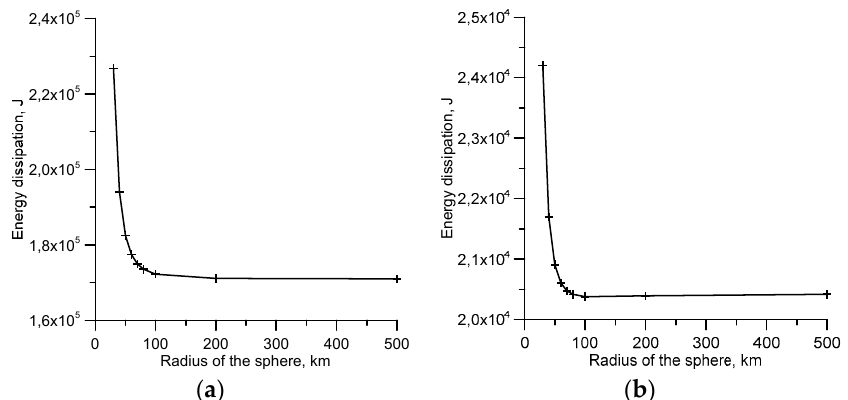
Figure 13. Energy transported through hemispheres of di ff erent radii all having their center at the strike point. ( a ) First return strokes; ( b ) subsequent return